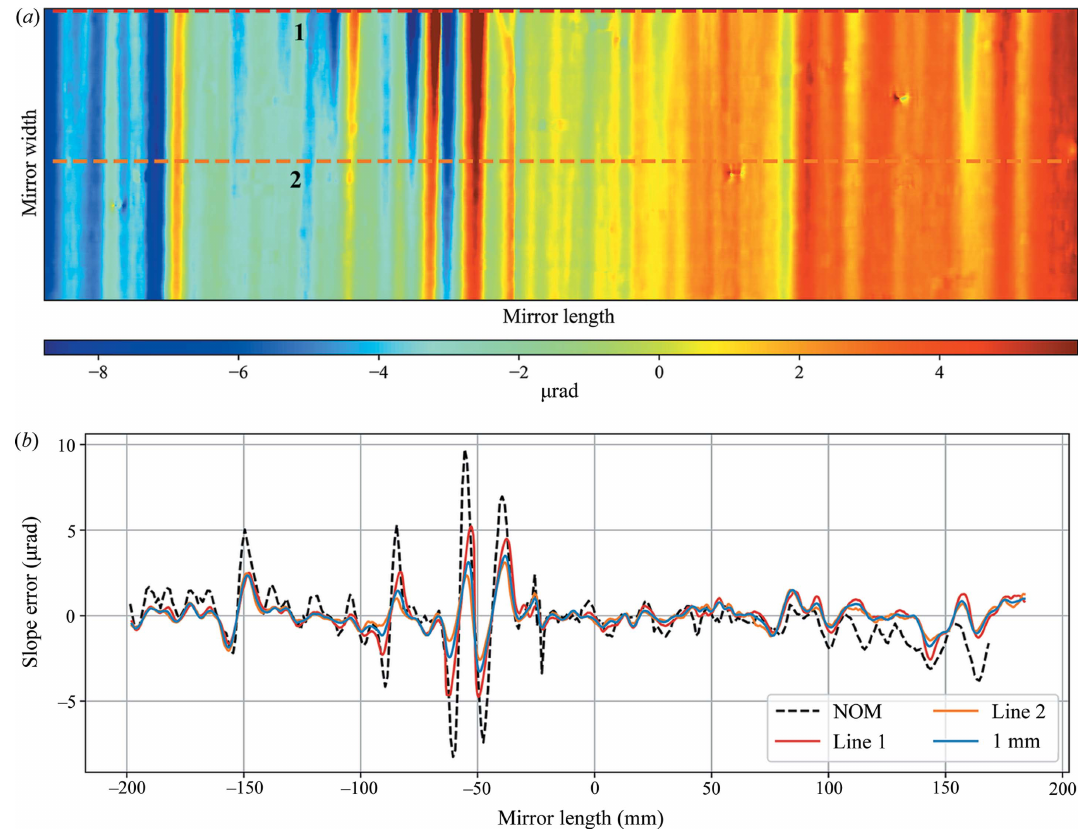
Figure 7 ( a ) Calculated wavefront slope error using the differential-mode XSS technique. Slope errors along the dashed orange line (centre) and red line (upper edge) were extracted for comparion with the Diamond-NOM metrology results. An area of (cid:3) 1 mm width (half the image) from the 2D map of the wavefront slope error was extracted to match the size of the probe used for the ex situ measurement. The calculated slope errors within this area were averaged along the mirror width. ( b ) Slope errors projected back to the mirror plane. The Diamond-NOM result is shown as a dashed black line. The red and orange lines correspond to the upper edge and the centre of the measured area, respectively. The blue line is the averaged slope error corresponding to a 1 mm mirror